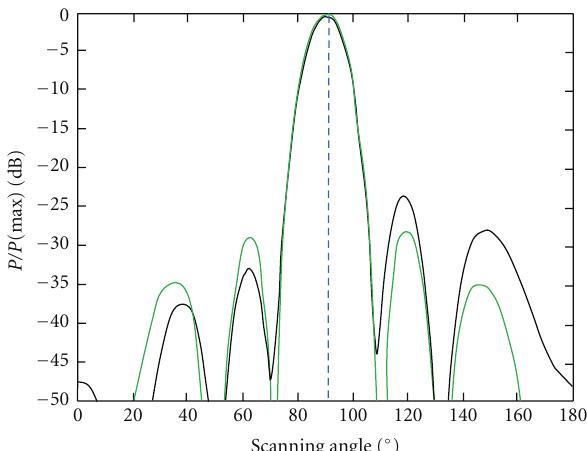
Figure 5: The beam pattern received with 18 neurons in the hidden layer—following